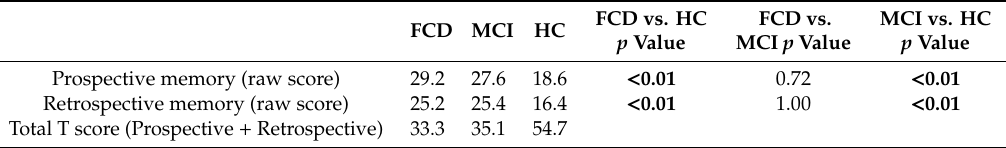
Table 2. Mean scores on the Prospective and Retrospective Memory